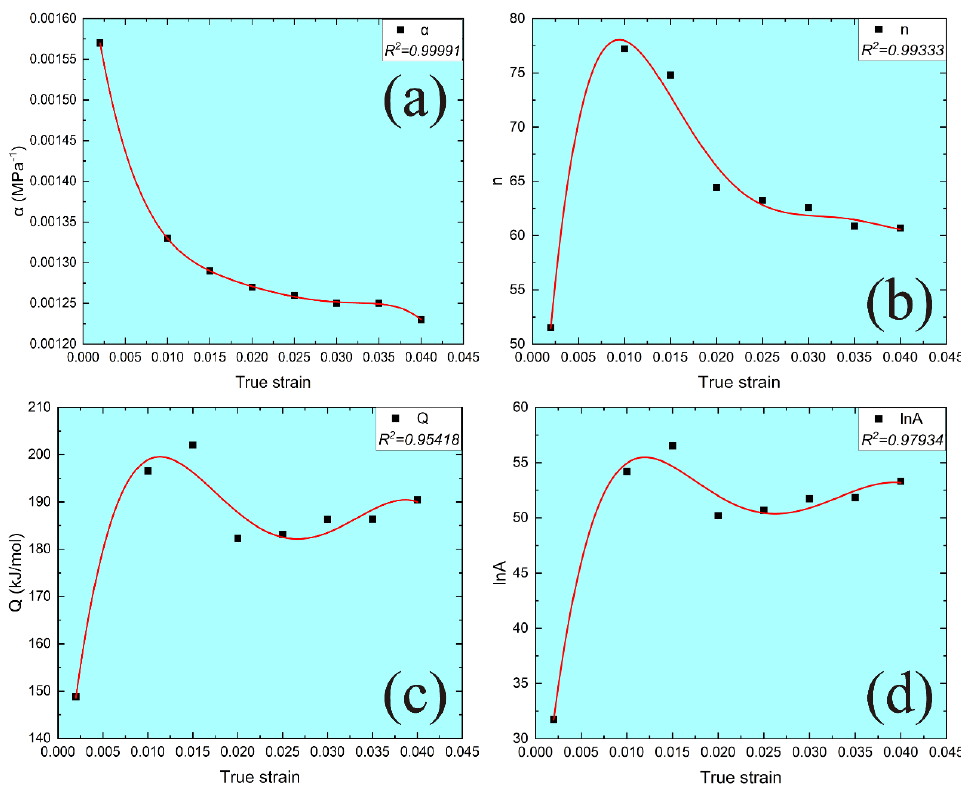
Figure 8. Relationships between true strain and different material parameters at different true strains: ( a ) α ; ( b ) n ; ( c ) Q ; ( d ) ln A